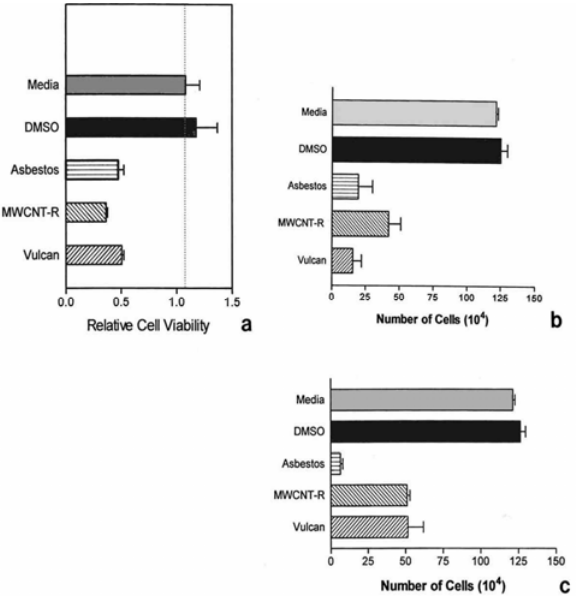
Figure 15: Comparative cytotoxicites of chrysotile asbestos surrogate BC, and surrogate carbon nanotube aggregates (MWCNT-R) to murine macrophage cells at a concentration of 5 µg/mL. (a) 2 days, (b) 7 days, (c) 14